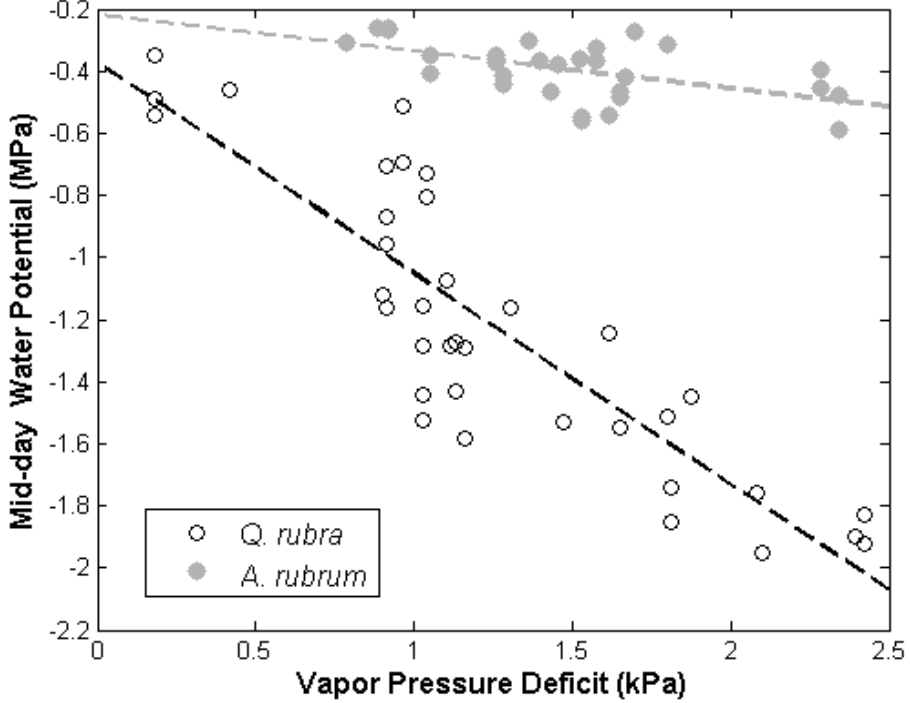
Figure 2. Relationship between mid-day leaf water potentials of Q. rubra and A. rubrum and sub-canopy vapor pressure deficit. A. rubrum shows very mild response to VPD while Q. rubra ’s response slope to VPD is significantly